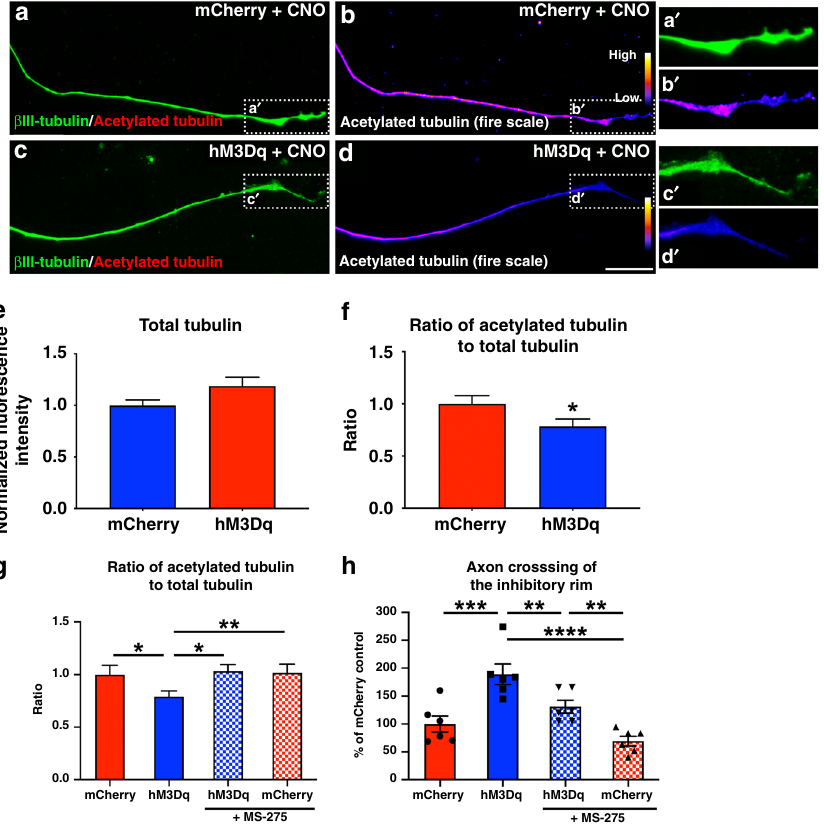
Fig. 8 Chemogenetic activation of adult DRGs decreases the ratio of acetylated to total tubulin in the distal axon to enhance extension on inhibitory substrates. a – f Representative images of the distal-most portion of axons from mCherry + ( a , b ) or hM3Dq + ( c , d ) DRGs stained for β III-tubulin (green) and acetylated tubulin (red in a and c ; standard fi re scale pseudo-color in b and d ). Images were taken 24 h after replating and CNO treatment. The distal- most 50 µ m portion of axons growing from mCherry + neurons and chemogenetically activated, hM3Dq + neurons had a similar fl uorescence intensity for